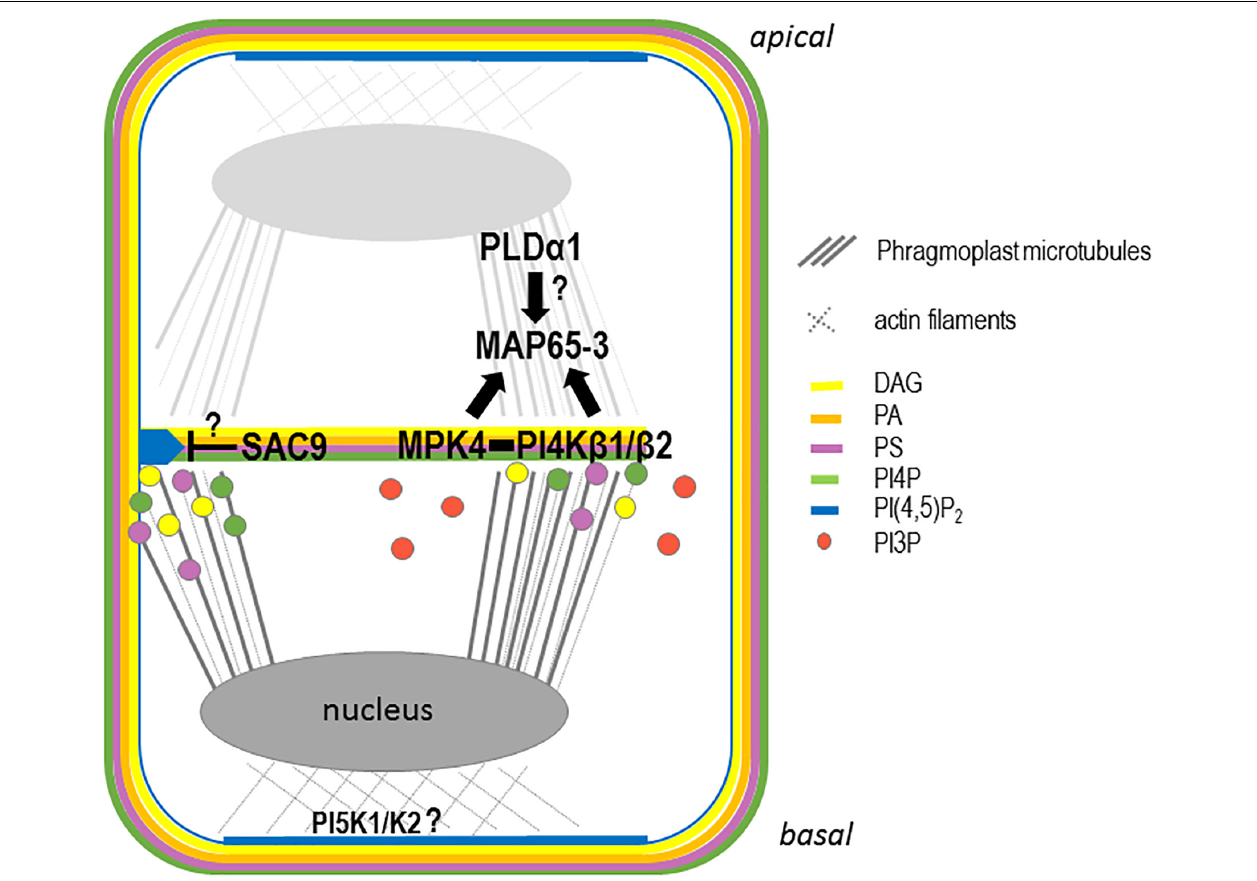
FIGURE 4 | Schematic representation of the anionic lipid metabolism during cell plate attachment. In late telophase, PI4P, PA, PS, and DAG are present at the growing cell plate probably through trafficking from the golgi and, or TGN. Additional synthesis of PI4P directly at the cell plate could be achieve via the PI4PK β 1/ β 2 enzymes. At this stage, PI(4,5)P 2 is accumulating at the apical/basal region of the cell via the action of the PIP5K1 and PIP5K2 enzymes, leading to an accumulation of the actin cytoskeleton at the apical/basal region of the cell. In parallel, PI4PK β 1/ β 2 produce locally PI4P at the growing cell plate regulating MAP65-3 directly or indirectly via MPK4. At this stage, PLD1 might regulates the PA pattering at the cell plate also impacting the function of MAP65 family members. During cell plate growth, PI(4,5)P 2 is excluded from the cell plate. When the cell plate attached to the mother cell wall, the PI(4,5)P 2 diffusion to the entire cell plate might be restricted by the action of a 5-phosphatase such as